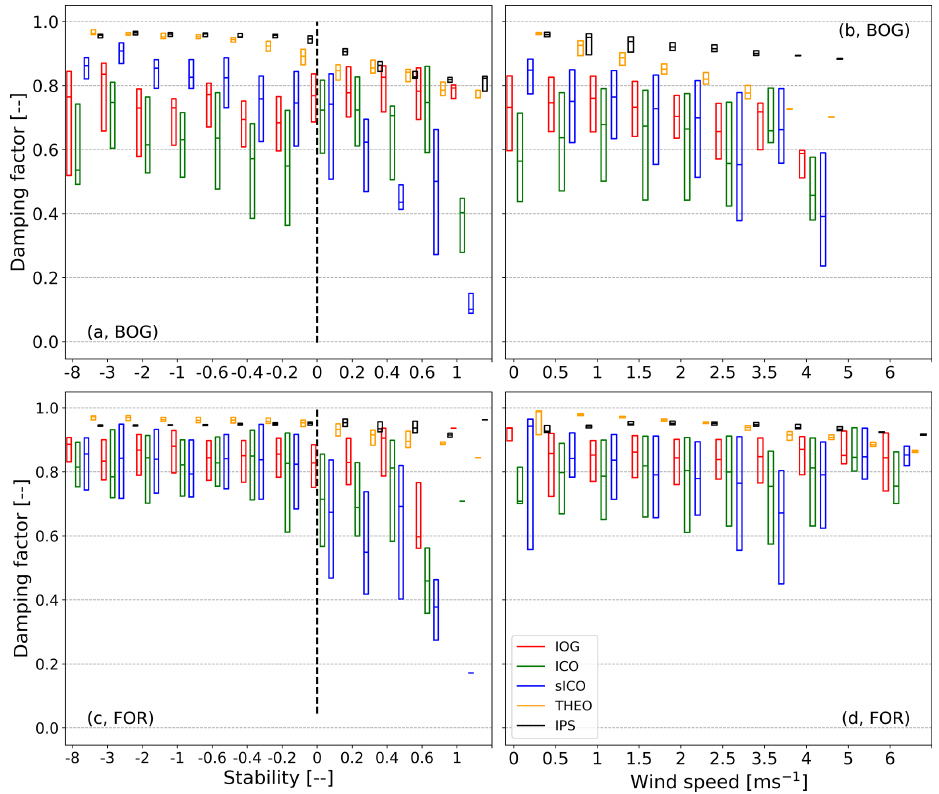
Figure 7. Dependency of the flux damping factor ( α ) on stability and wind speed classes as box plots without whiskers and outliers (box frame is the 25% to 75% interquartile ranges (IQR); the bold line is the median). Each damping estimation method is assigned a different color (red: IOG, green: ICO, blue: sICO, orange: THEO, black: IPS). Panels (a, b) refer to the BOG site and (c, d) to the FOR